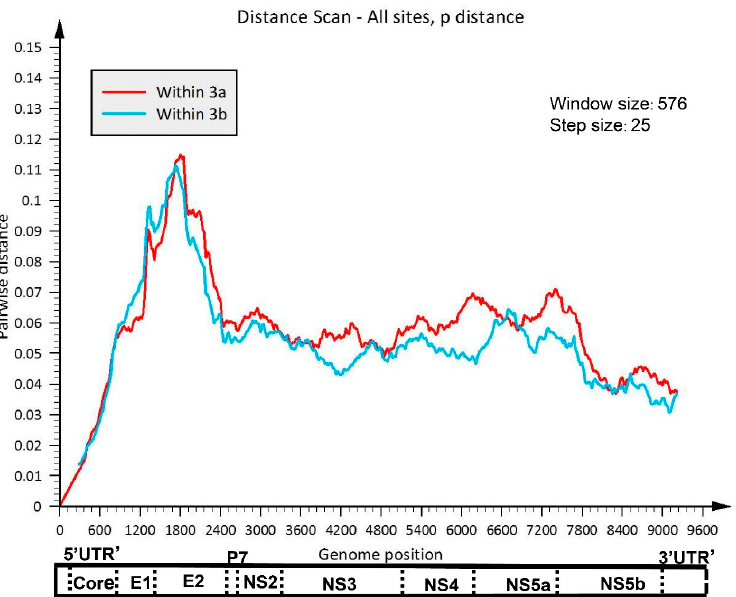
Figure 1. Full-genome sliding window plot for GT-3a and GT-3b nucleotide diversity (%). The GT-3a and GT-3b were plotted separately in color-coded solid lines.